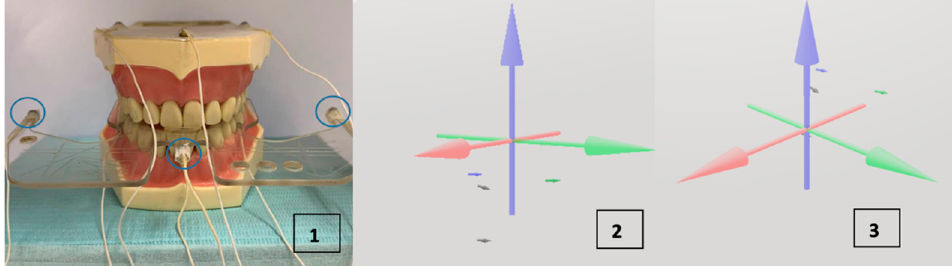
Figure 3. ( 1 ) Phantom with Bite Plane. The Bite Plane is placed on the occlusal plane and its sensors are used to transfer the origin of the system to this plane. In blue, the Bite Plane sensors. ( 2 ) The system without making the Head Correction. ( 3 ) The Head Correction done with the Bite Plane. The interincisal sensor is barely below the coordinate origin.